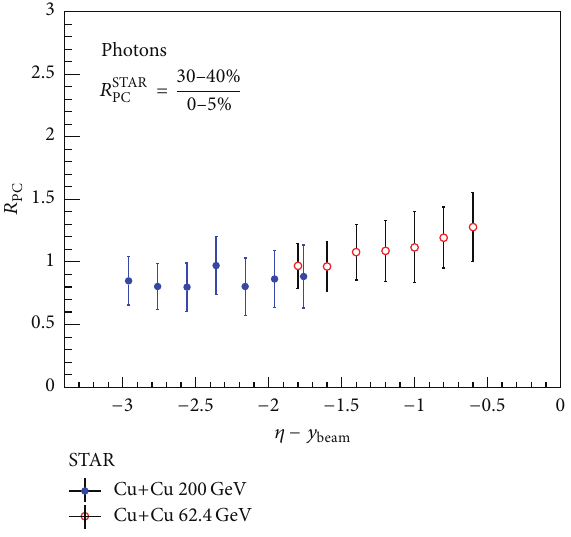
Figure 31: 𝑅 of photons as a function of 𝜂 󸀠 = 𝜂 − 𝑦 PC collisions for different